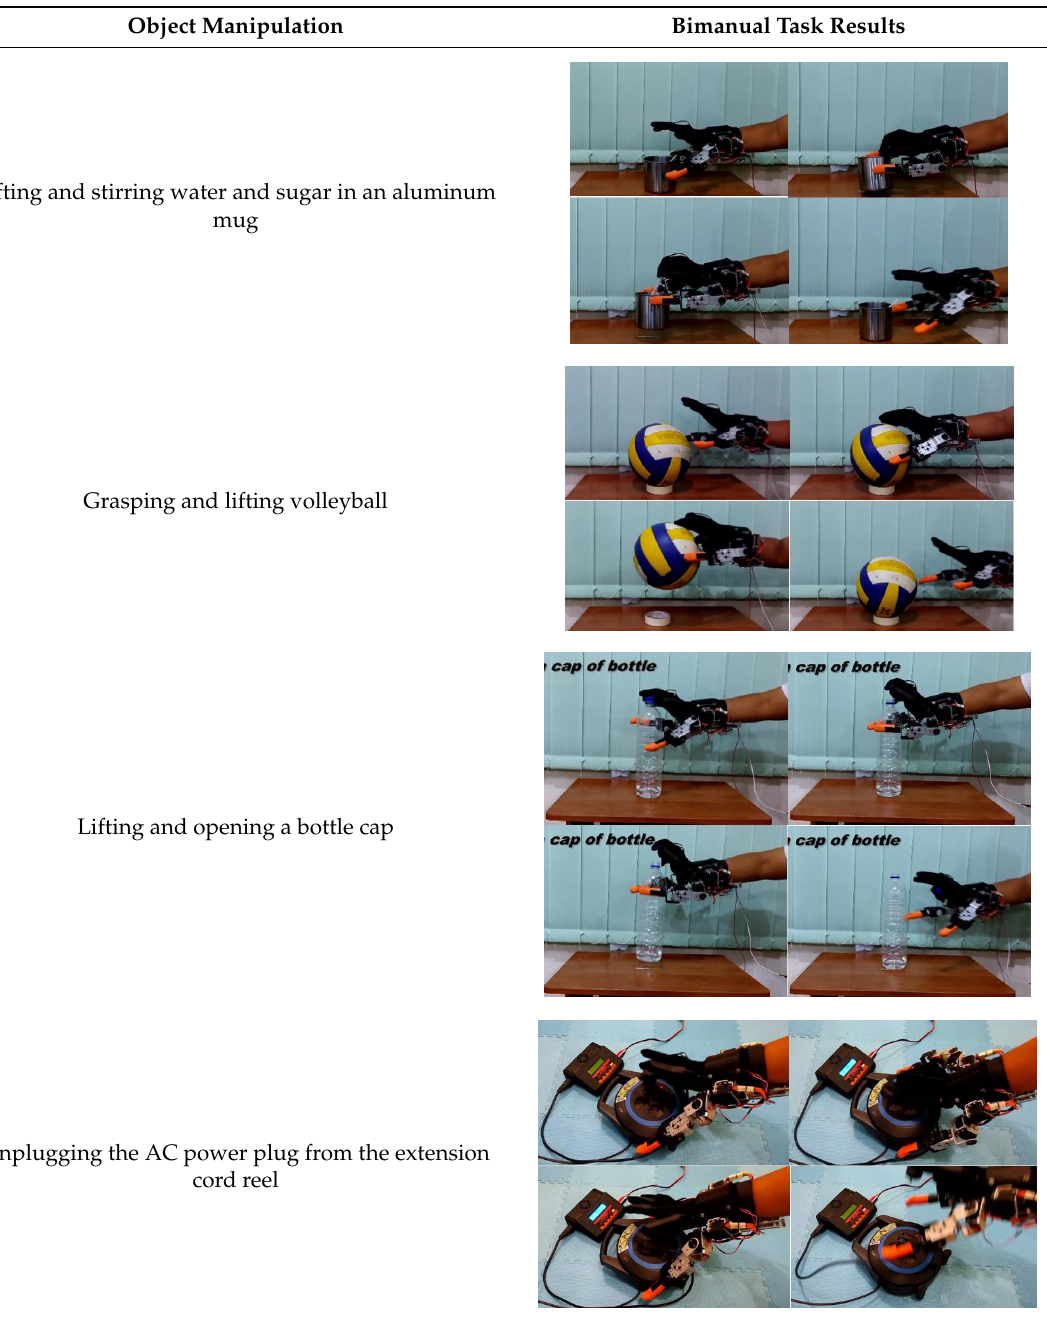
Figure 11. Fingertip trajectories: ( a ) RT; ( b ) RF. Table 5. Bimanual manipulation assist test with the developed extra robotic fingers.